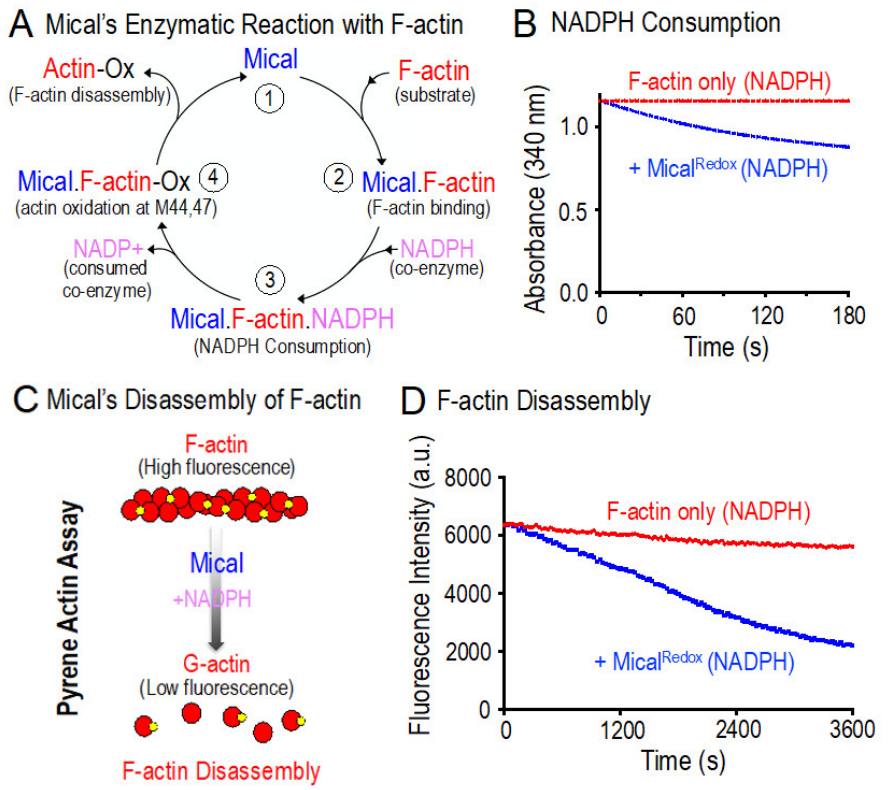
Figure 4. Analysis of the activity of purified Mical Redox protein. ( A ) Mical’s enzymatic reaction with F-actin. This model is based on our results (reviewed in [9–12]) that Mical (1) physically associates with its substrate F-actin (2), which triggers Mical’s enzymatic activity to convert its co-enzyme nicotinamide adenine dinucleotide phosphate (NADPH) to NADP + (3). Mical then oxidizes (Ox) F-actin subunits on their methionine (M) 44 and M47 residues (4), triggering F-actin disassembly. Note that for simplicity, details, such as the presence of molecular oxygen (O 2 ) and conversion of flavin adenine dinucleotide (FAD) to FADH 2 and reoxidation back FAD , have been left off the model. ( B ) Mical uses the pyridine nucleotide NADPH as a co-enzyme in its Redox enzymatic reactions [13–15,20]. We therefore sought to confirm the enzyme activity of the purified Mical Redox protein by characterizing its NADPH consumption activity. As judged by the decrease in absorbance over time (NADPH absorbs light at 340 nm, while NADP + does not), our results revealed that our Mical Redox protein converts NADPH to NADP + and therefore has enzyme activity. Both conditions contain NADPH. [NADPH] = 200 µ M; [Mical Redox ] = 50 nM; [F-actin] = 18.4 µ M. ( C , D ) Pyrene-labeled actin depolymerization assays demonstrate purified Mical Redox protein’s ability to disassemble F-actin. ( C ) The fluorescence of pyrene-labeled actin is higher when actin is present in its polymerized form. ( D ) Similar to previous results with Mical [13–15,20], our newly purified Mical Redox protein induces actin depolymerization in the presence of its NADPH coenzyme as judged by a Pyrene-actin depolymerization assay, where the fluorescence of polymerized actin decreases as actin depolymerizes. [Mical Redox ] = 50 nM; [NADPH] = 100 µ M; [F-actin] = 4.65 µ